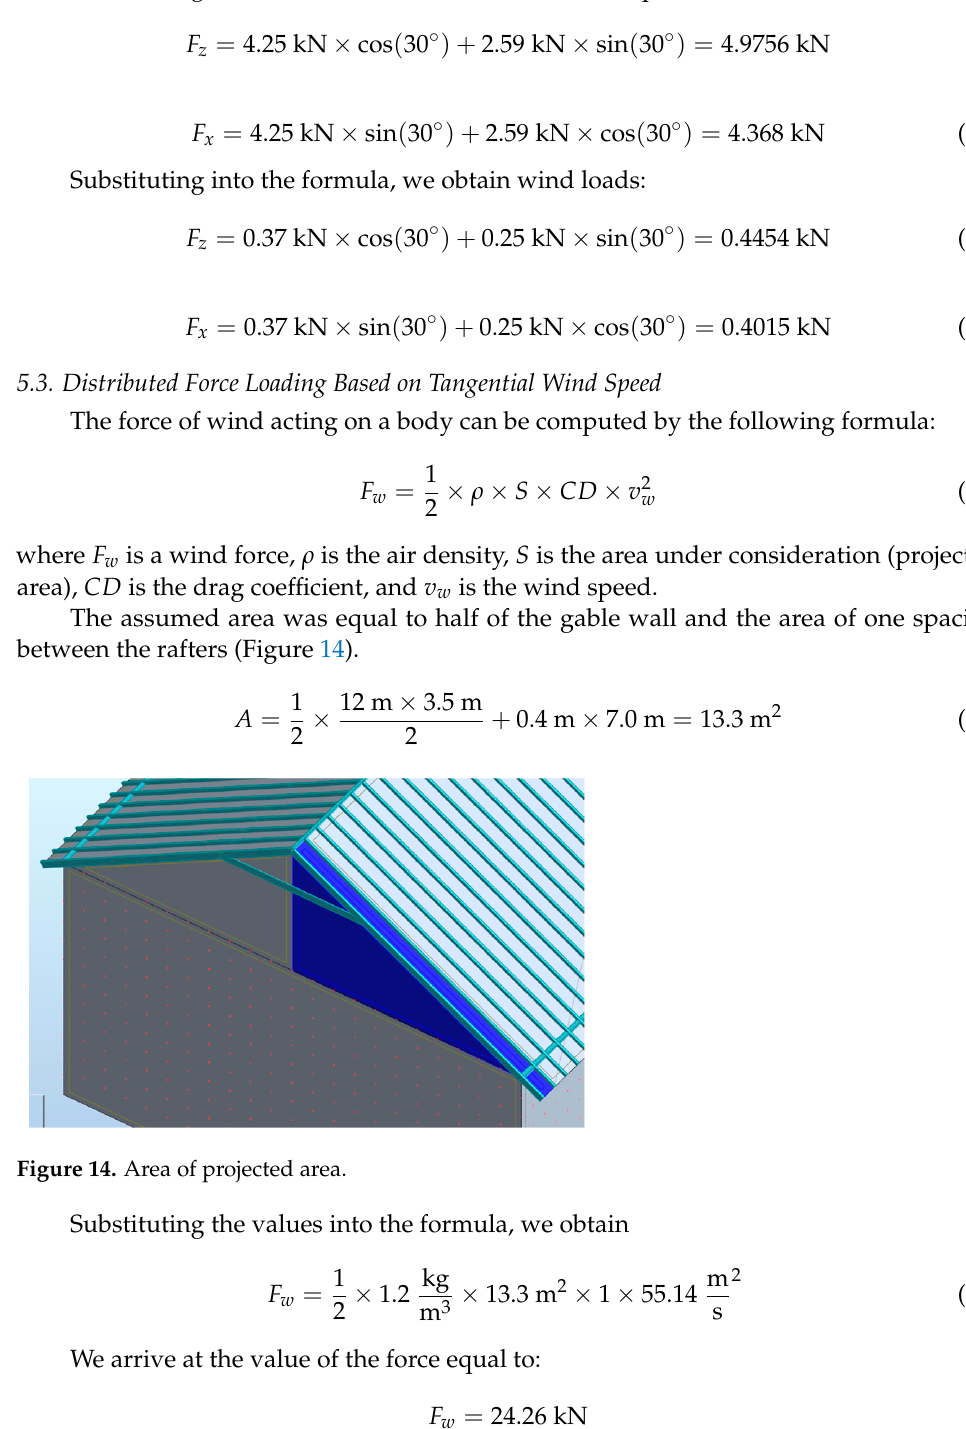
( c ) Figure 15. Scheme of rafter support on the wall: ( a ) front view, ( b ) side view, ( c ) 3D view.